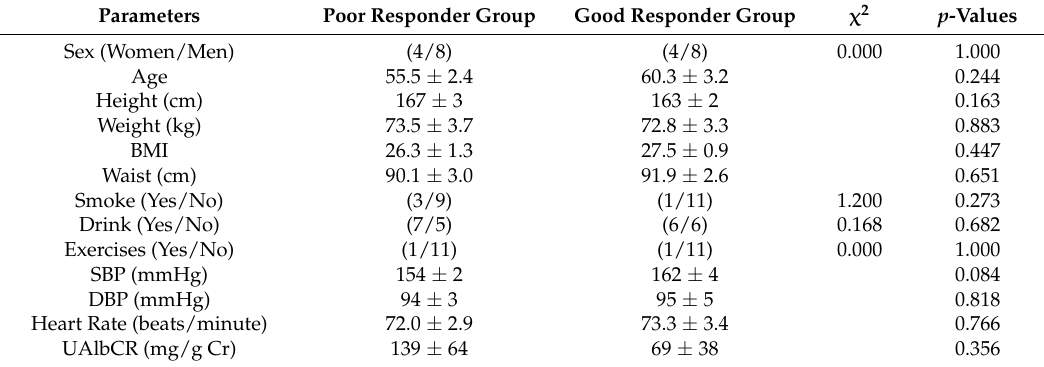
Figure 4. The urinary angiotensinogen/creatinine ratio was decreased after the treatment with olmesartan. One-way repeated measures ANOVA followed by Tukey’s multiple comparisons test were used to compare values over the time course. p < 0.05 was considered as statistically significant (* p < 0.05). UAGTCR, average urinary angiotensinogen (AGT)/creatinine. Table 3. Clinical characteristics of the poor responder group and the good responder group at the baseline.